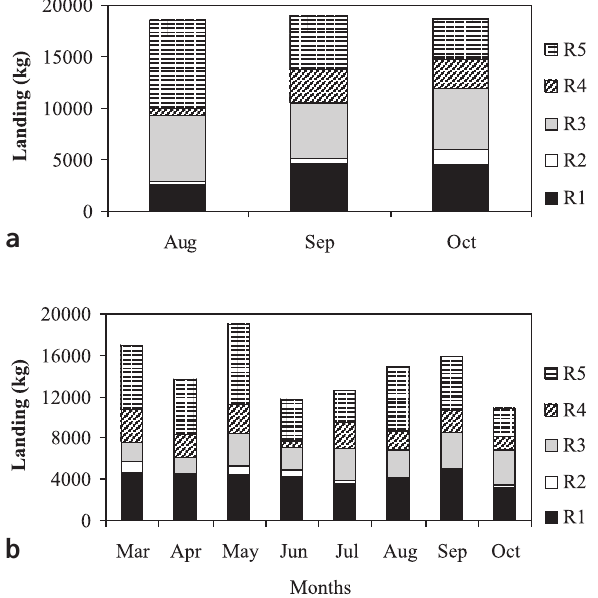
Fig. 3. Monthly landing of catch by region (R1 = region 1; R2 = region 2; R3 = region 3; R4 = region 4; R5 = region 5) of the rio Cuiabá in 2000 (a) and 2001 (b).